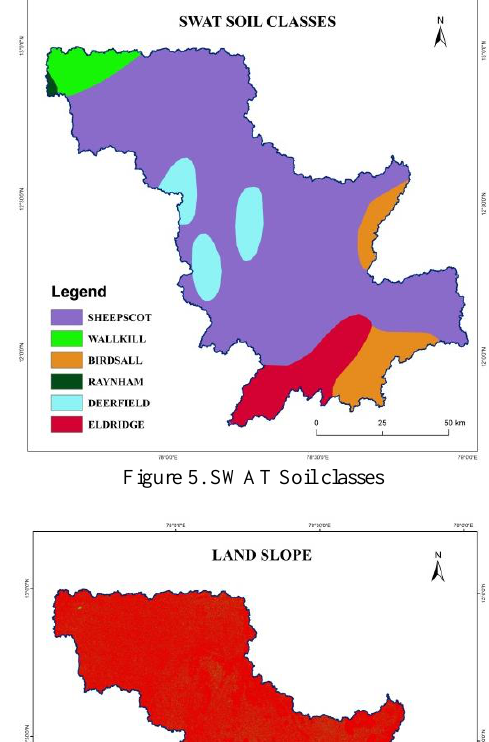
Figure 6. SWAT Land slope